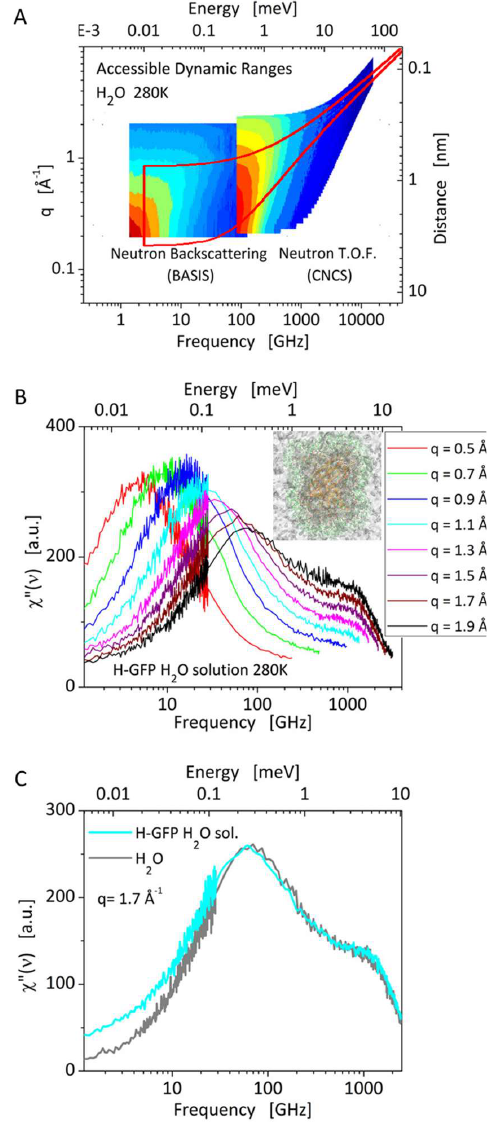
Fig. 7 . Broadband neutron scattering capabilities are highly desirable to study the dynamics of water. (A) Recent work studying water hydrating Green Fluorescent Protein was compelled to utilize multiple spectrometers to achieve an experimental window covering the ns-ps dynamics of water. The capabilities of BWAVES would be an ideal fit for such studies. (B) Currently, Q-resolved spectra must be sliced and stitched in a cumbersome process from instruments with mismatched resolution and dynamic window. (C) Ultimately, this window is important to probe different water populations around model biomolecules. The data are adapted from [23].